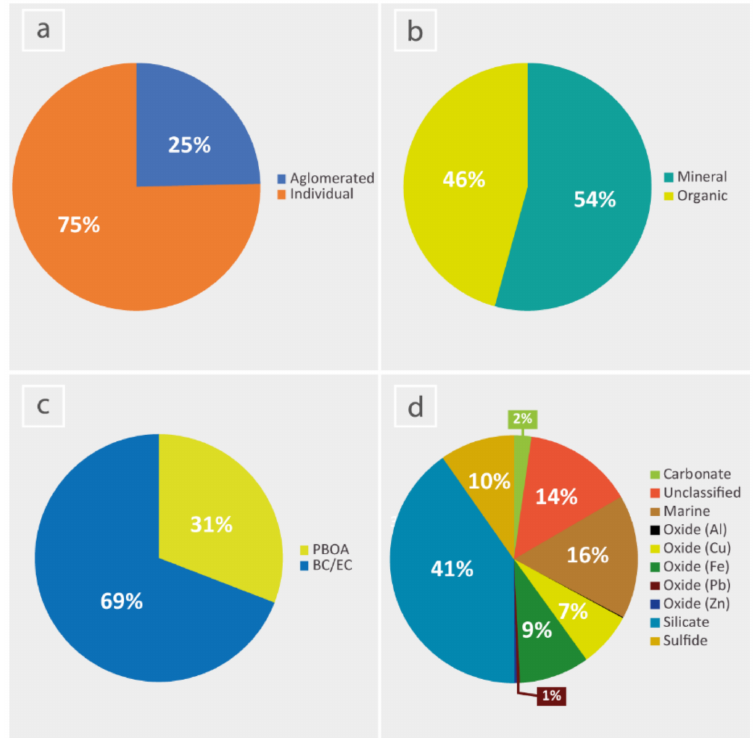
Figure 4. Graphical representation of all the groups defined for the PM 10 analyzed by SEM-EDX: ( a ) the first classification level, ( b ) individual group classification, ( c ) organic group sub-classes, and ( d ) mineral group sub-classes.